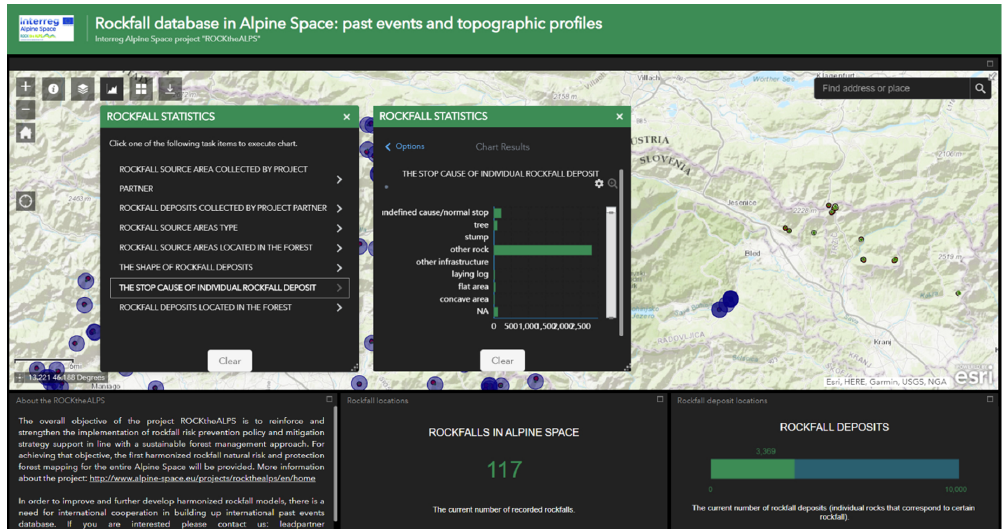
Figure 7. Available statistics about both features (source and deposit area). The statistics can be calculated for the whole Web Map extent or for a spatially limited area that can either be chosen with a different spatial extent of the Web Map or by using a user-defined area (e.g., spatial selection via point, line, or